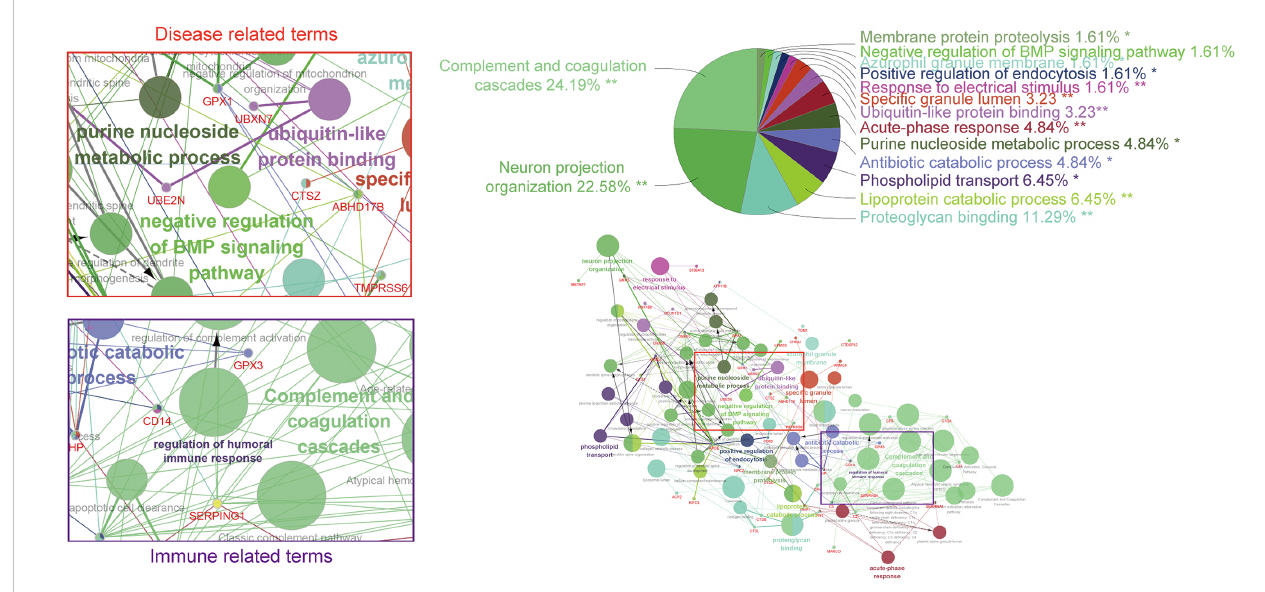
FIGURE 5 GO and KEGG analysis based on co-regulated genes with the SPKKP signature score in pan-cancer. Each node represents a gene ontology term, while the edges are quantitative representations of shared gene membership. The different colors of the nodes represent the different groups generated. The pie chart represents the ClueGo pathway groups by the percentage of gene ontology (GO) terms